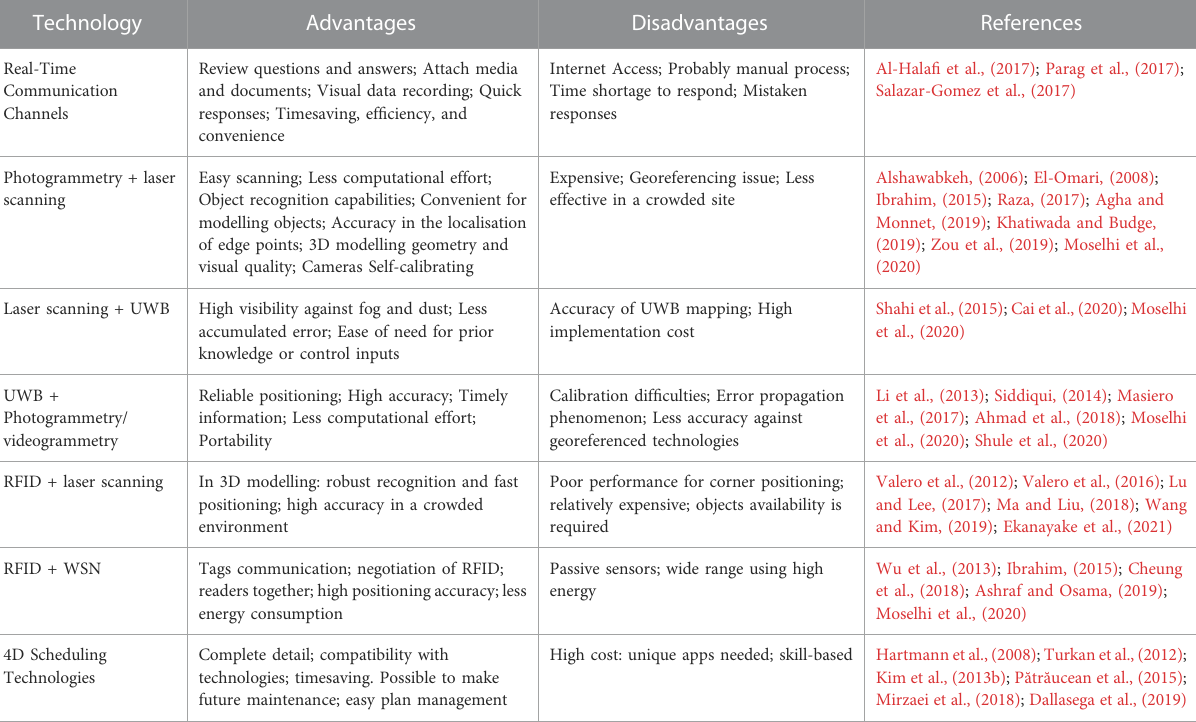
TABLE 9 Key advantages and disadvantages: combined digital